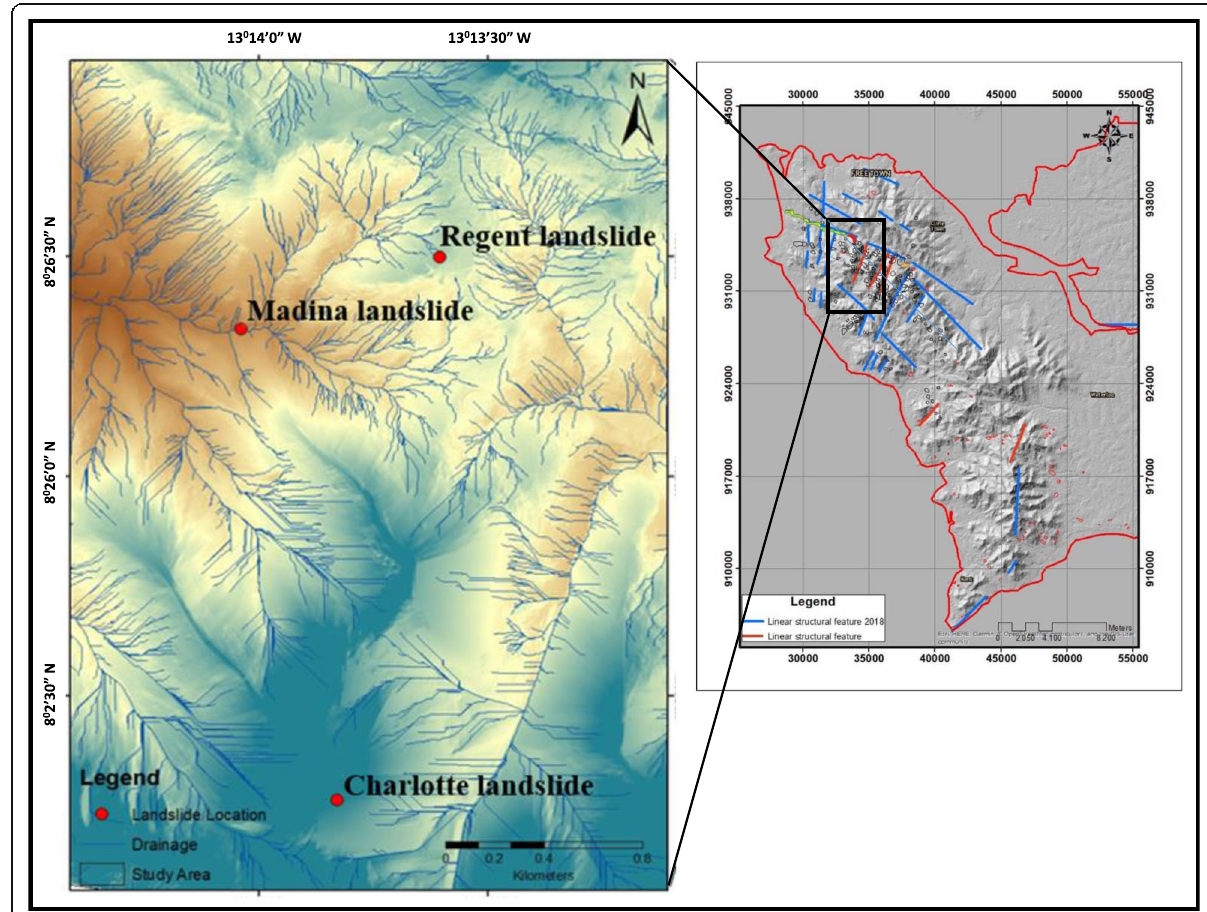
Fig. 1 Study area showing landslide locations projected from the regional lineament map of